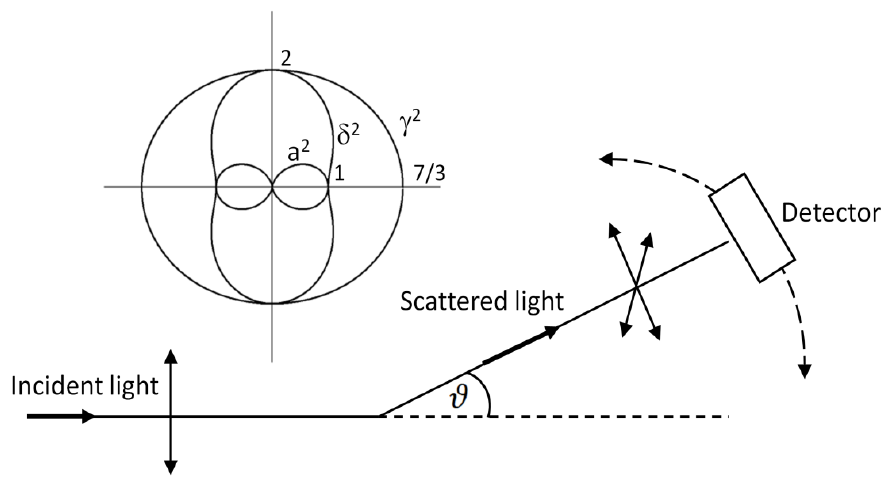
Figure 4. Angular dependence of the Raman signal. When both the incident and scattered fields are polarized parallel to the scattering plane or when one field is polarized parallel and the latter is unpolarized, the detected Raman intensity will be angular-dependent. Angular dependences for molecules with a dominant contribution of 𝑎 2 , 𝛾 2 and 𝛿 2 respectively when moving the detector by an angle 𝜗 from 0° to 360° and no analyser is used are indicated in the inset.